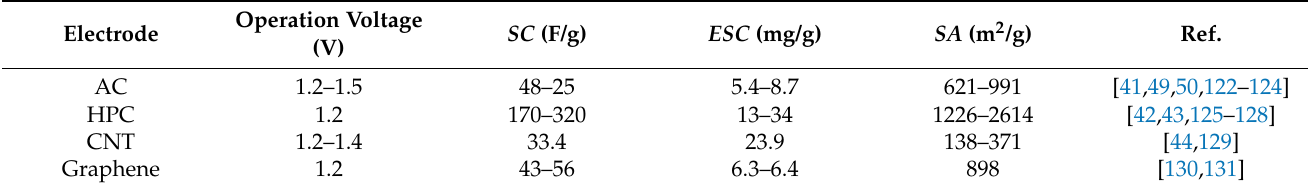
Table 2. Summary of properties of main carbon-based CDI electrodes for desalination.